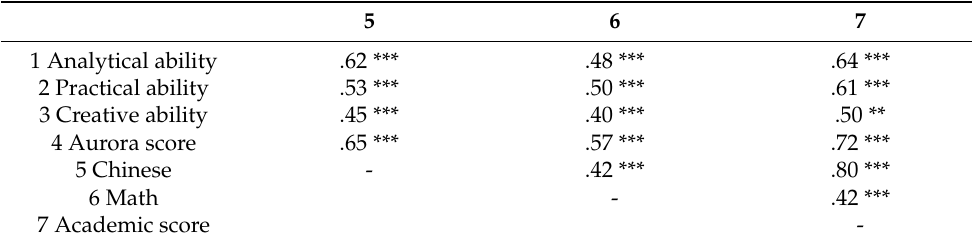
Table 8. Correlation matrix among Aurora, and academic scores (N = 188).